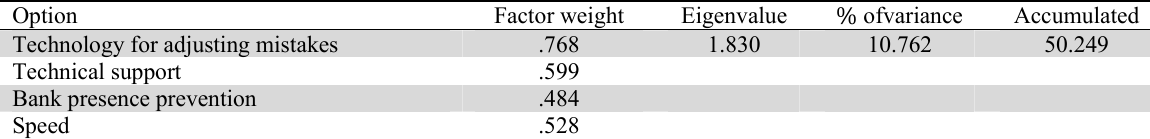
The summary of factors associated with facilities Option